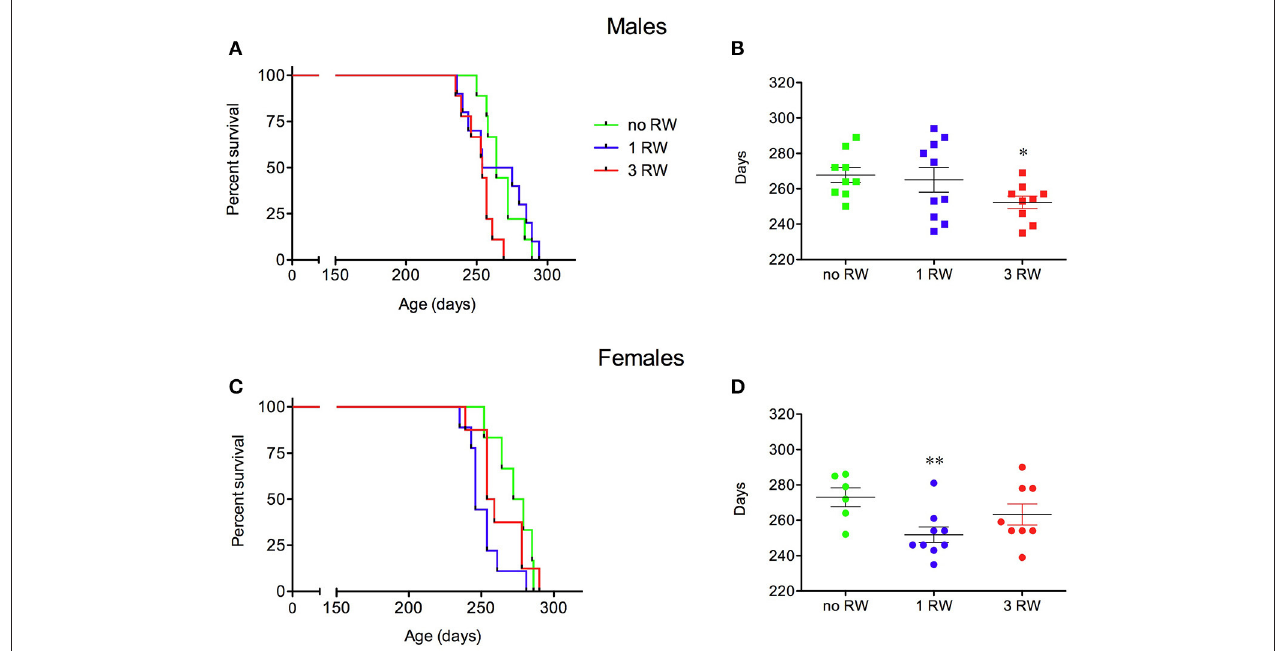
FIGURE 3 | Effect of exercise experience on survival of SOD1G93A low-copy mice. (A–C) Kaplan-Meier survival curves for male (A) and female (C) mice from the exercise groups (1 and 3 RW) and from a group never exposed to running wheel exercise (no RW). (B–D) Scatter plot of survival days (mean ± s.e.m.) for male (B) and female (D) mice from the three experimental groups. * P < 0.05, no RW vs. 3 RW, t -test; ** P < 0.01, no RW vs. 1 RW, t -test. n = 6–10 per